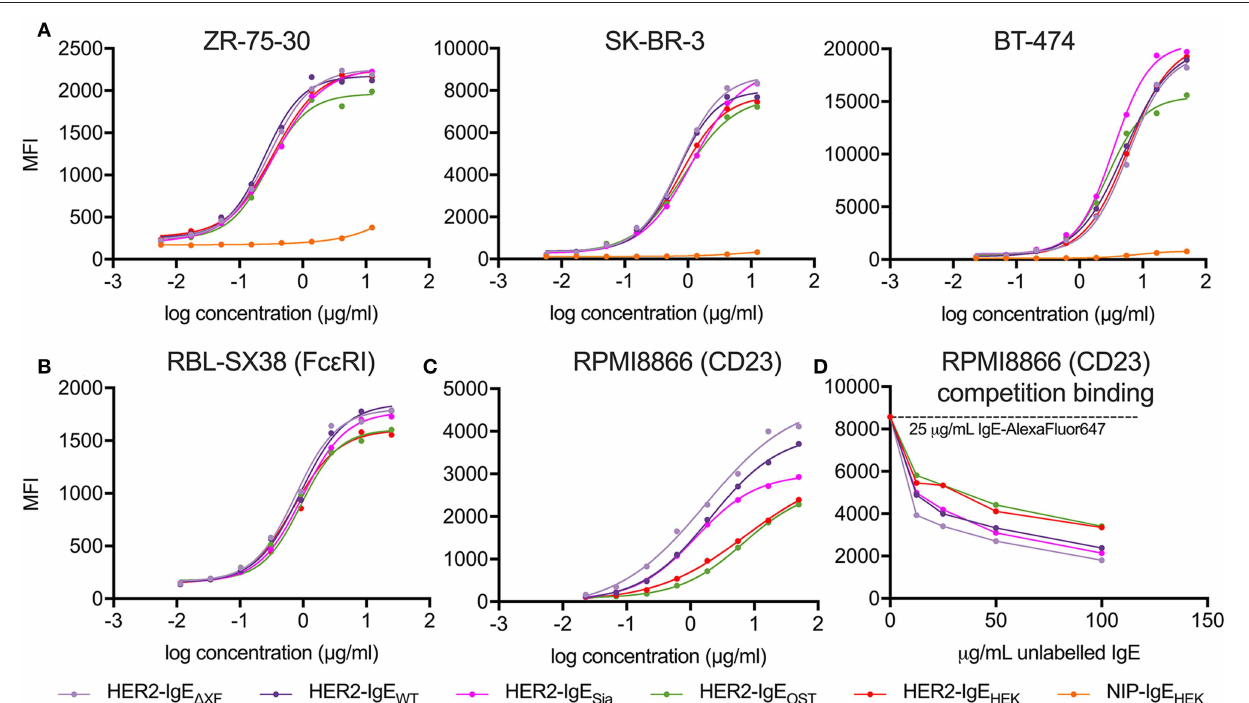
FIGURE 3 | Analysis of antibody target antigen and Fc receptors binding. (A) Target antigen recognition of IgE variants on HER2-overexpressing cancer cell lines. All HER2-IgE variants bound to the target antigen in a similar dose-dependent manner in all cell lines used; the negative control (isotype NIP-IgE HEK ) does not bind. (B) Recognition of tetrameric Fc ε RI on RBL-SX38 cells. All HER2-IgE variants bound to the receptor in a similar dose-dependent manner. (C) Recognition of CD23 on RPMI8866 cells. All HER2-IgE variants bound to the receptor in a dose-dependent manner. Differences between the binding behaviors of the variants are observable here. (D) Competition binding assay of CD23 on RPMI8866 cells. Graphs are representative of two (in some cases more) independent experiments.